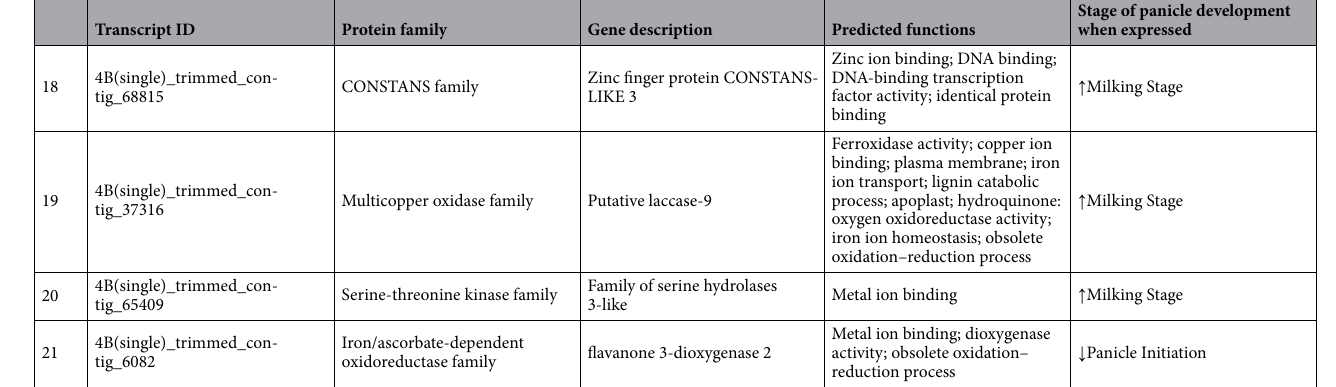
Table 5. List of transcripts along with their protein family having a functional association with minerals uptake in high Fe and Zn containing pearl millet genotypes